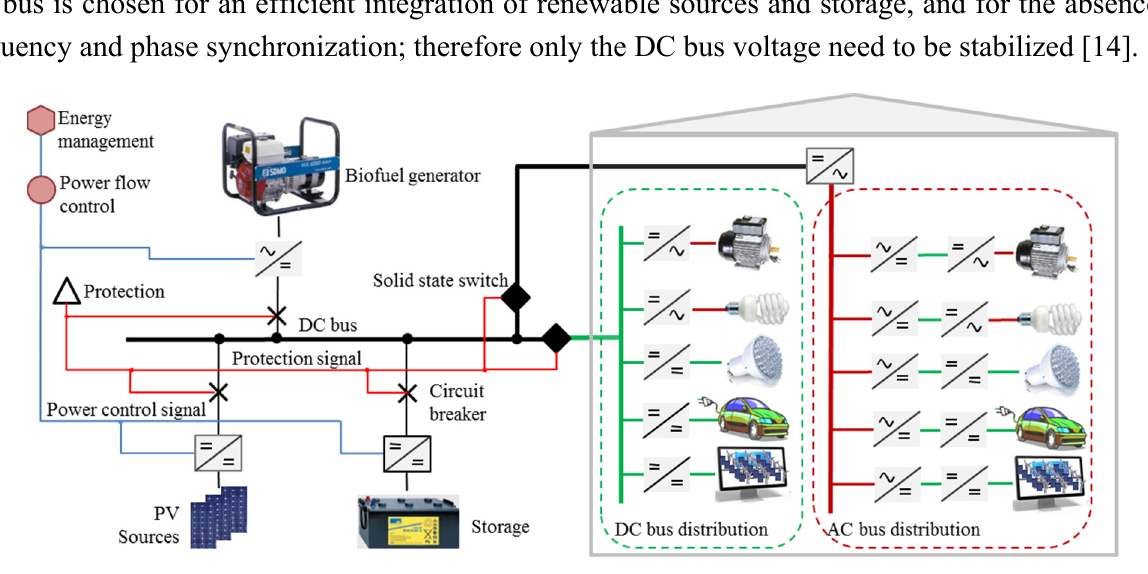
Figure 1. Isolated DC microgrid based on photovoltaic (PV) sources, storage and biofuel